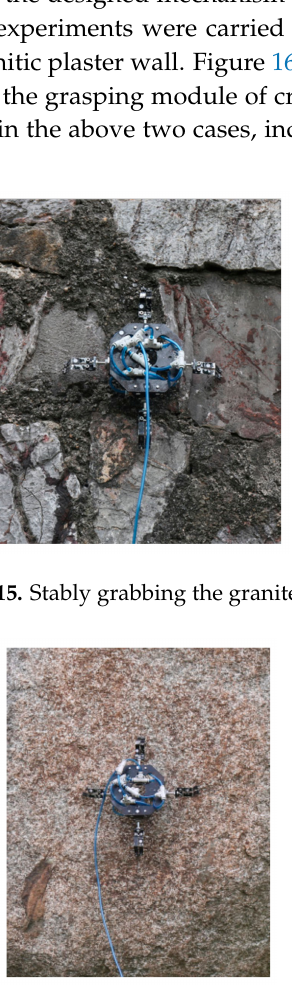
Figure 16. Stably grabbing the rough rock